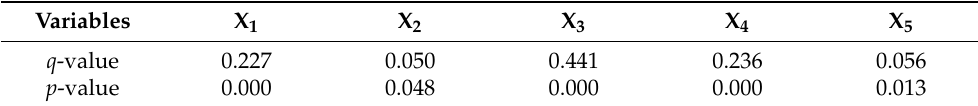
Table 9. The intensity of action of ANSP detection factor q